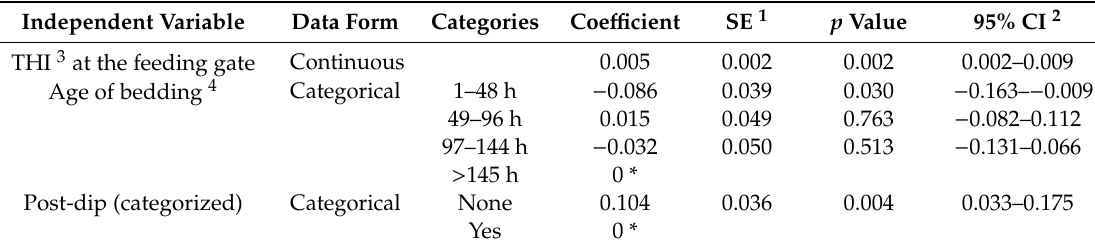
Table 9. Final generalized linear mixed model based on 120 farm visits describing risk factors ( = independent variable) associated with the ratio of coliform bacteria on total aerobic mesophilic teat-skin load on herd level ( = dependent variable).